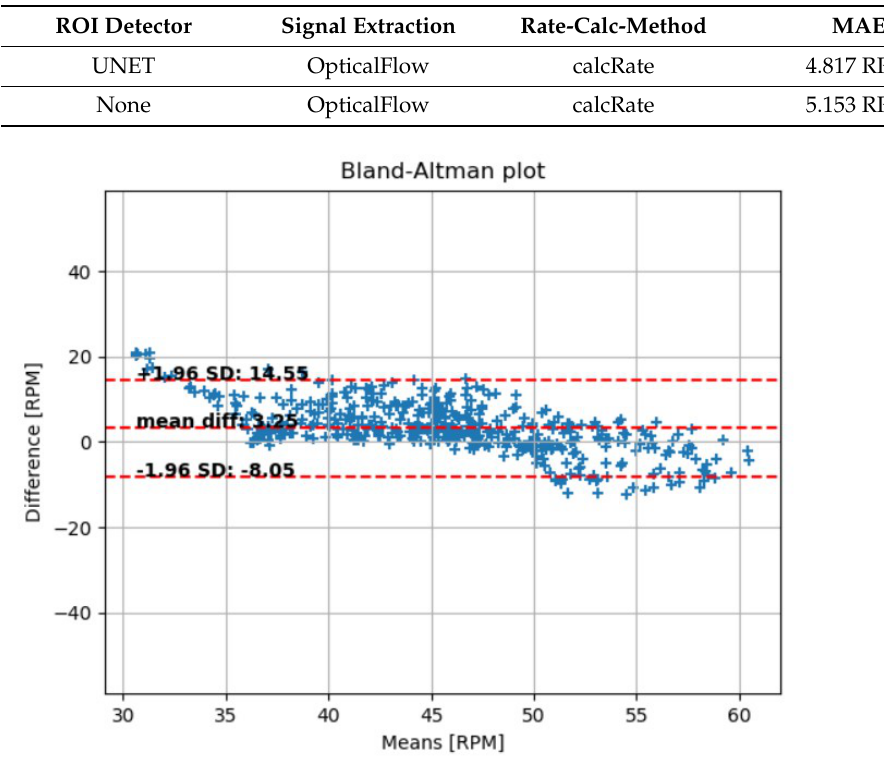
Figure 15. The Bland–Altman plot calculated for the error of OpticalFlow +